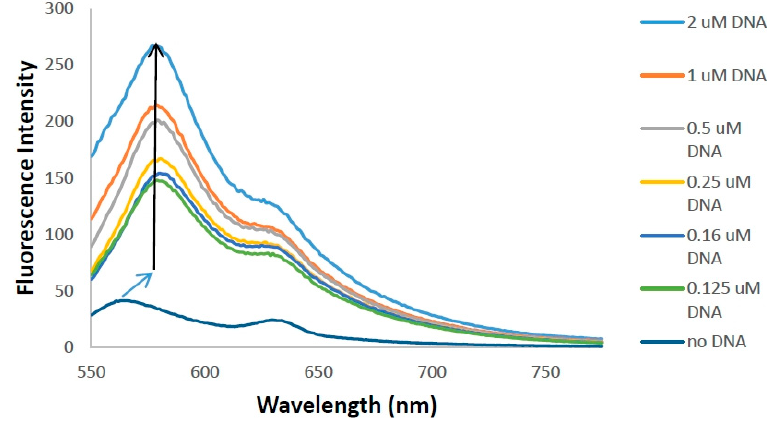
Figure 8. Emission spectra of dye 6b (10 μ M ) in Tris-HCl buffer with and without ct-DNA (excitation wavelength 520 nm).